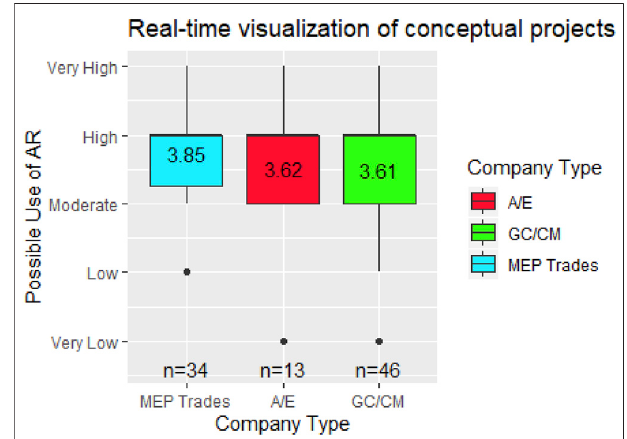
FIGURE 1 | Boxplot of the relationship between the Respondents ’ Perceived Usage of Virtual Planning and Sequencing and Respondents ’ Usage of AR in the Construction Industry. Notes: 0 — respondents have not experienced AR before and are not interested in the